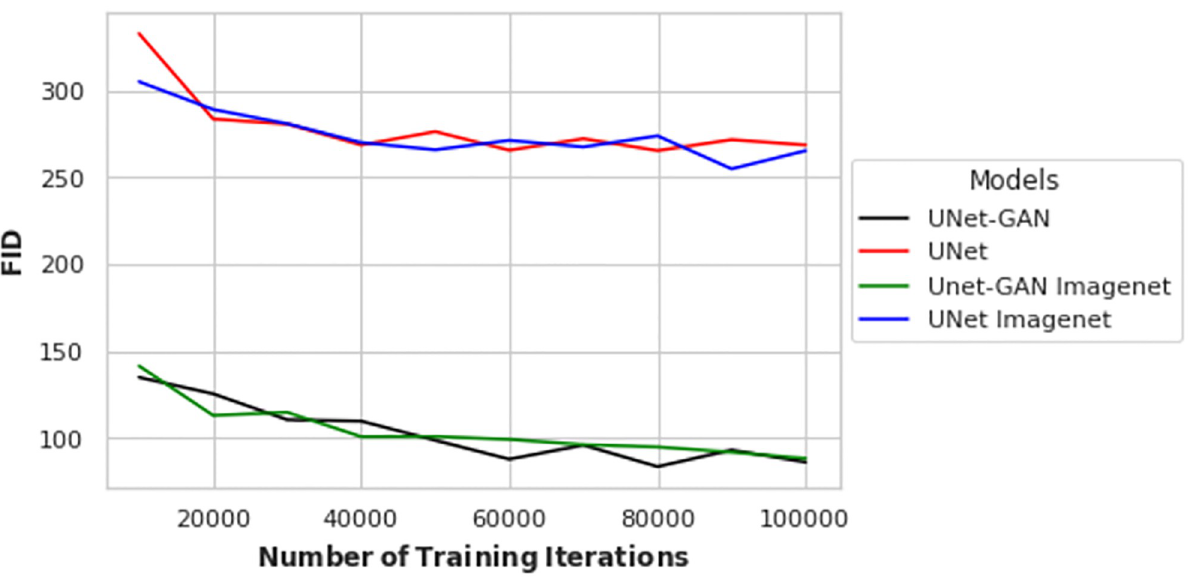
Fig 5. Reconstruction performances for the UNet-based architectures. FID scores and number of iterations for the UNet-based architectures.